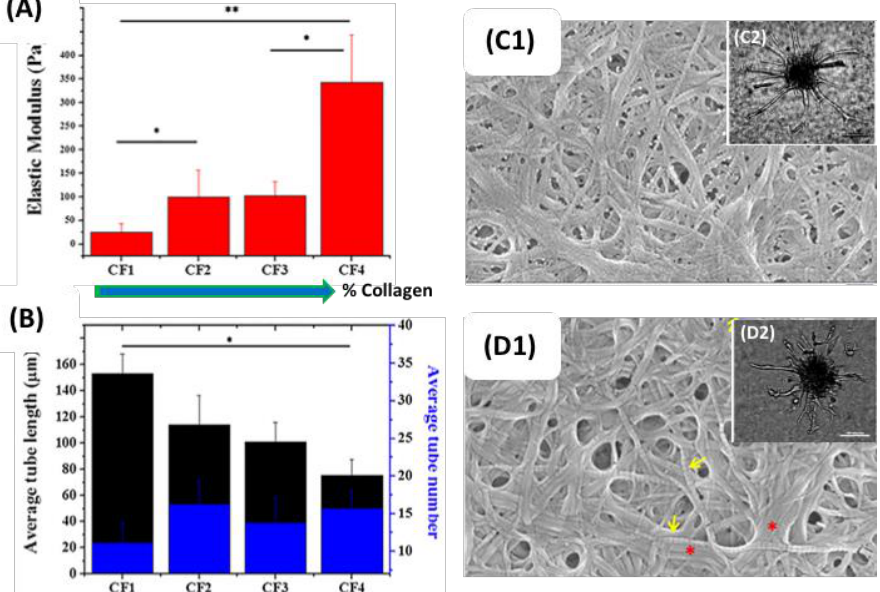
Figure 7. Angiogenesis by HUVECs cultured in Type I collagen-fibrin mixed hydrogels. Variation of ( A ) elastic modulus and ( B ) average tube length and tube number (collagen:fibrin weight ratio: CF1 1:4; CF2 2:3; CF3 3:2; CF4 4:1). SEM and optical images (as insets) for ( C ) CF2 and ( D ) CF3. ** p < 0.01, * p < 0.05. Yellow arrows indicate banded collagen fibrils. Red asterisks indicate bundles of fibrils. Adapted and reproduced with permission from [132]. Copyright 2018 Elsevier B.V.